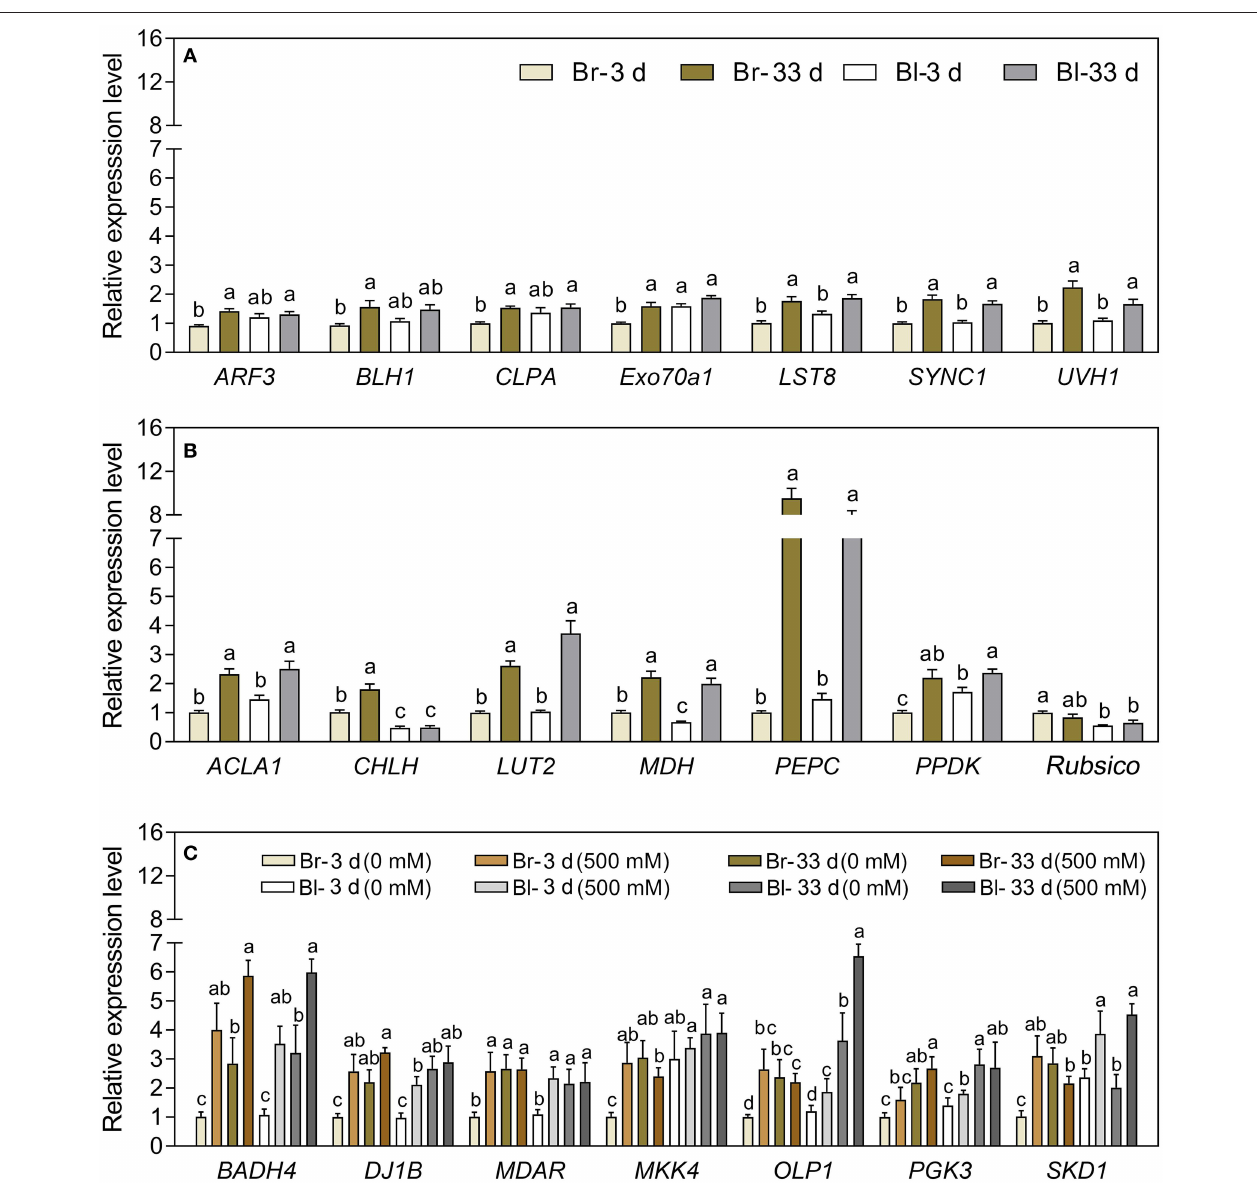
FIGURE 14 | Relative expression of 21 interested TDFs in seedlings of S. aralocaspica at different developmental stages or under different salt stress. (A) Development-related genes, (B) photosynthesis-related genes, and (C) salt stress response genes. 3 d and 33 d represent 3 and 33 days after seedling emergence. 0, 500 mM: different NaCl concentrations. Br, brown seedling; Bl, black seedling. Bars with different lowercase letters indicate a significant differences ( P < 0.05) of the same gene among different treatments according to Tukey’s test. Values are means ± SE of eight